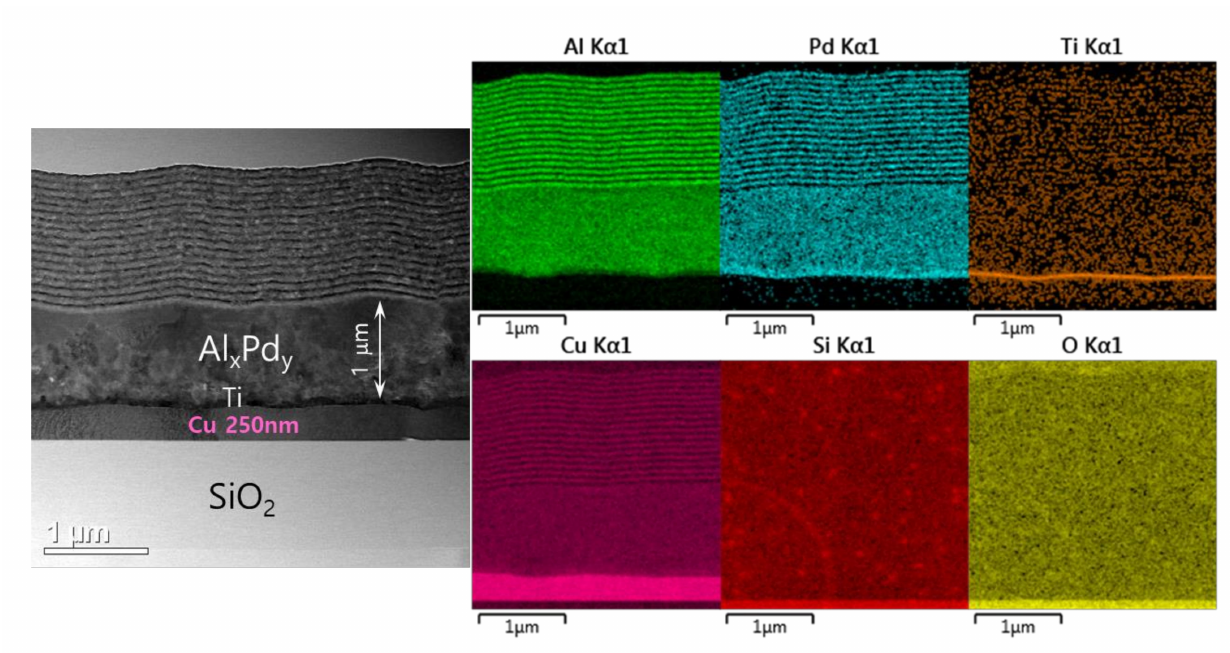
Figure 12. TEM cross section microstructure ( left ) and corresponding EDS elemental mappings ( right ) of Pd/Al-iRMS with a bilayer thickness of δ = 100 nm grown on a 250 nm Cu film-coated SiO 2